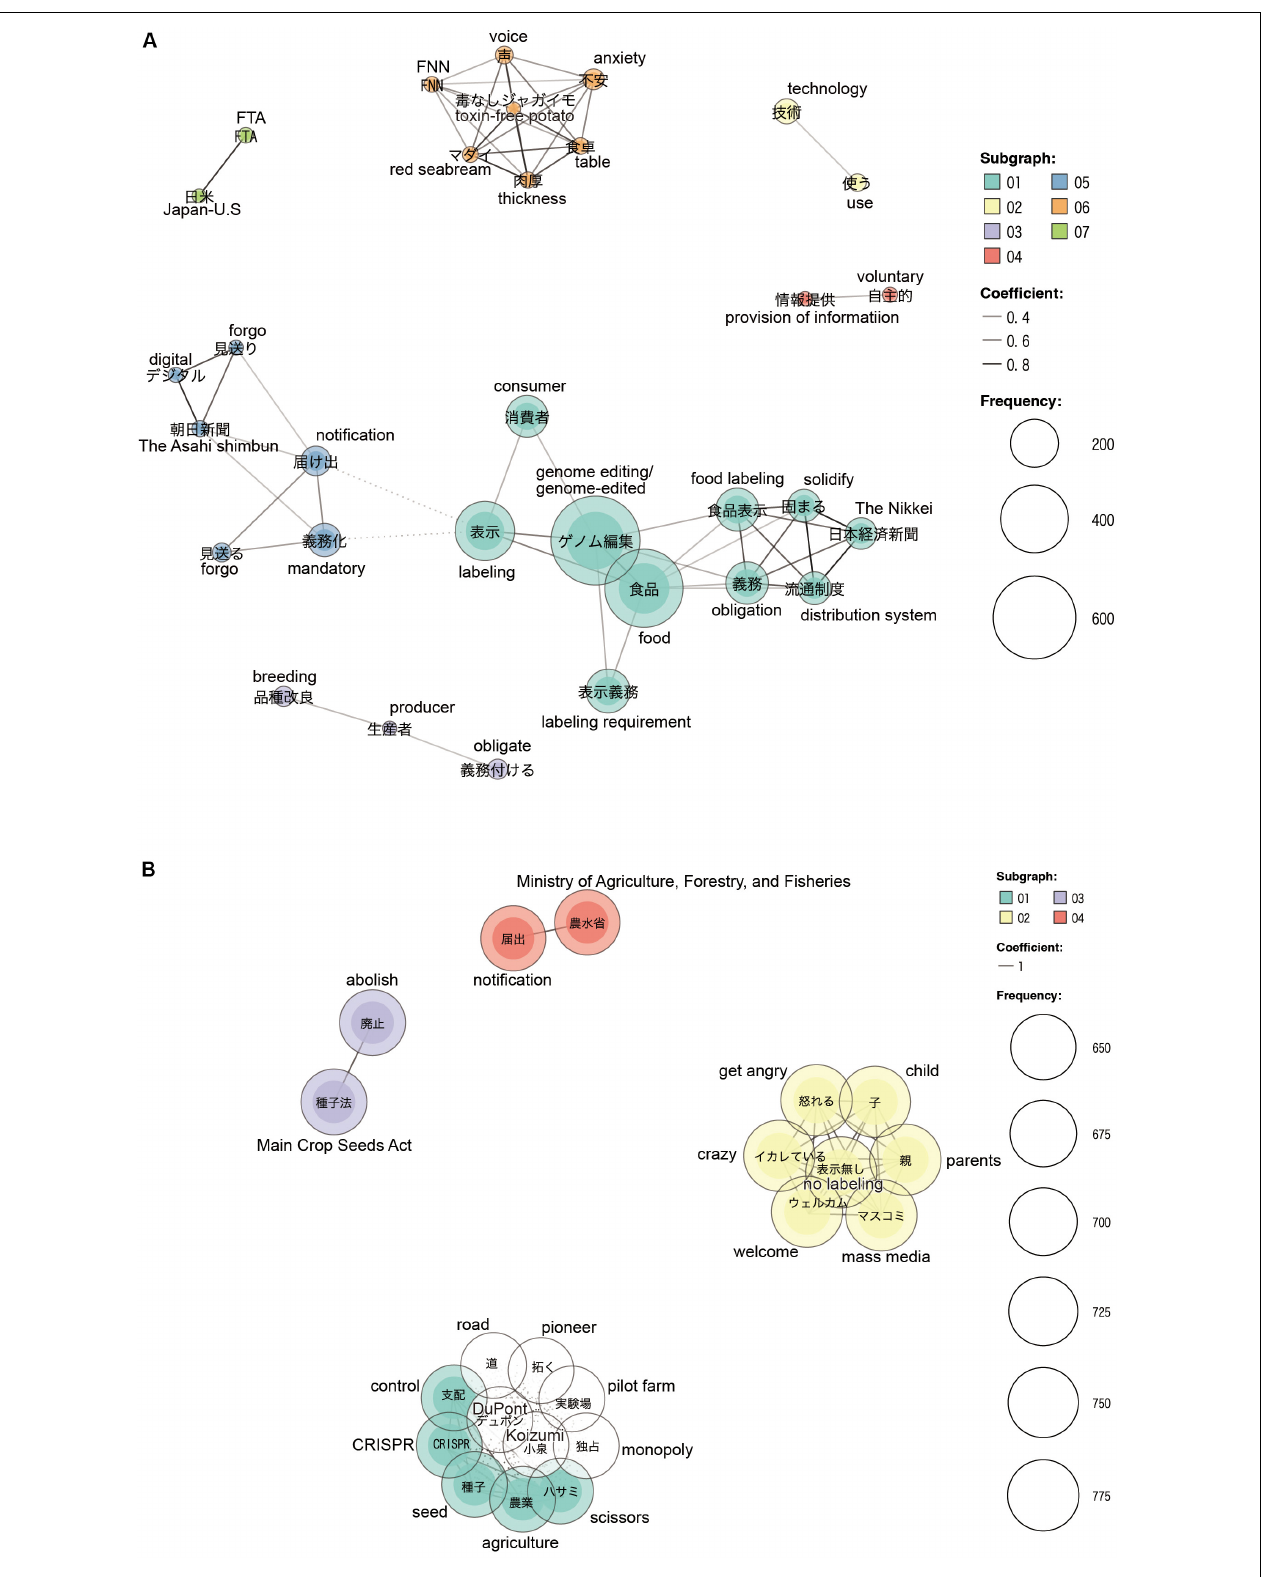
FIGURE 2 | Co-occurrence networks of words in tweets posted from September 19 to 22. (A) Co-occurrence network with only original and reply tweets, (B) co-occurrence network with all tweets including original tweets, reply tweets, and retweets.